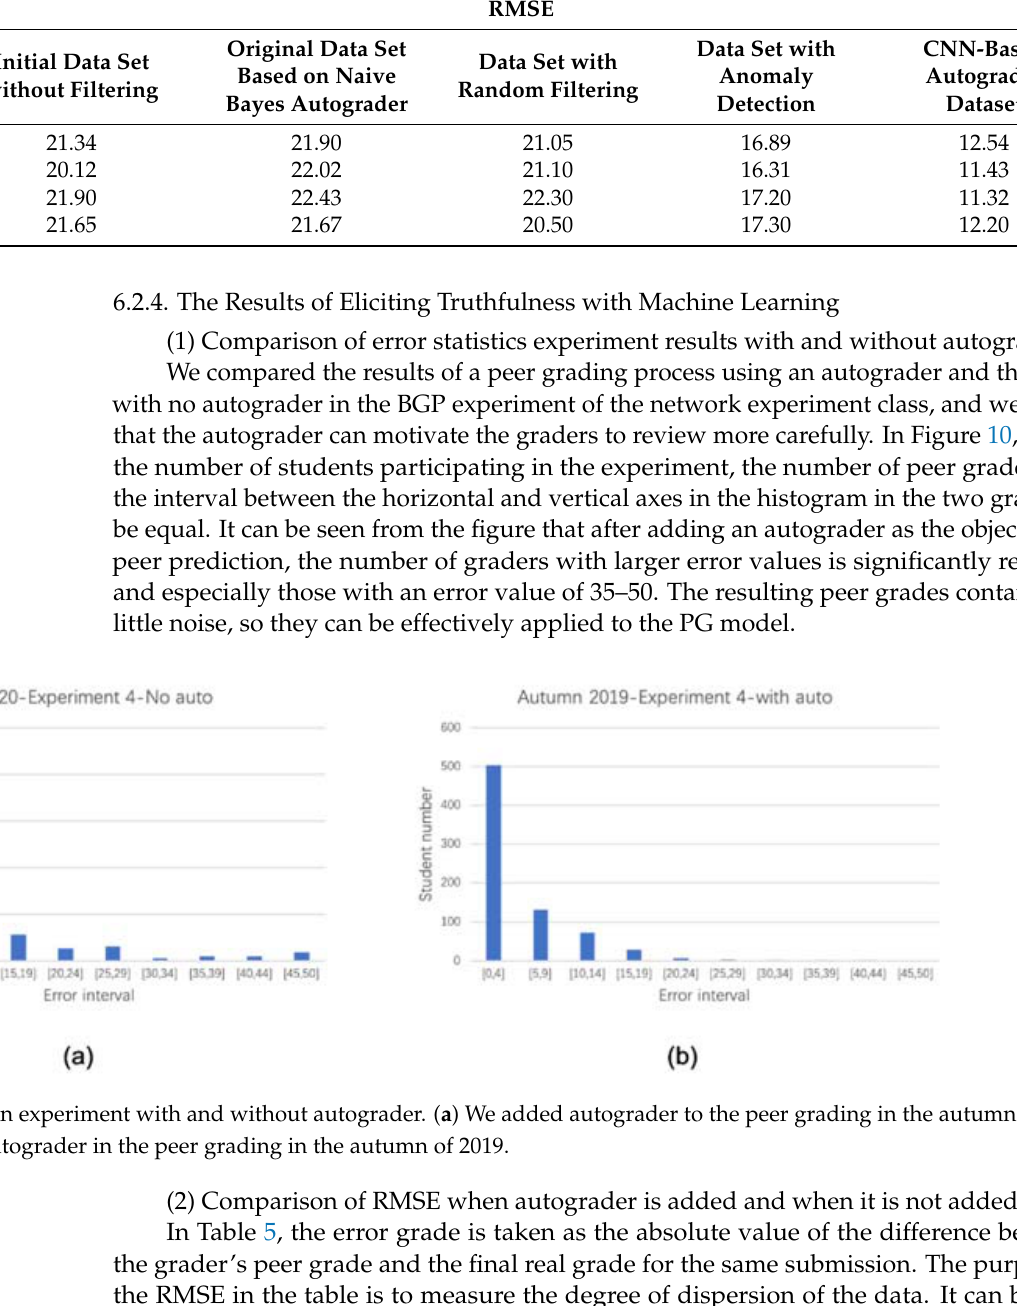
Table 5 Experimental results of the game process with and without autograder.